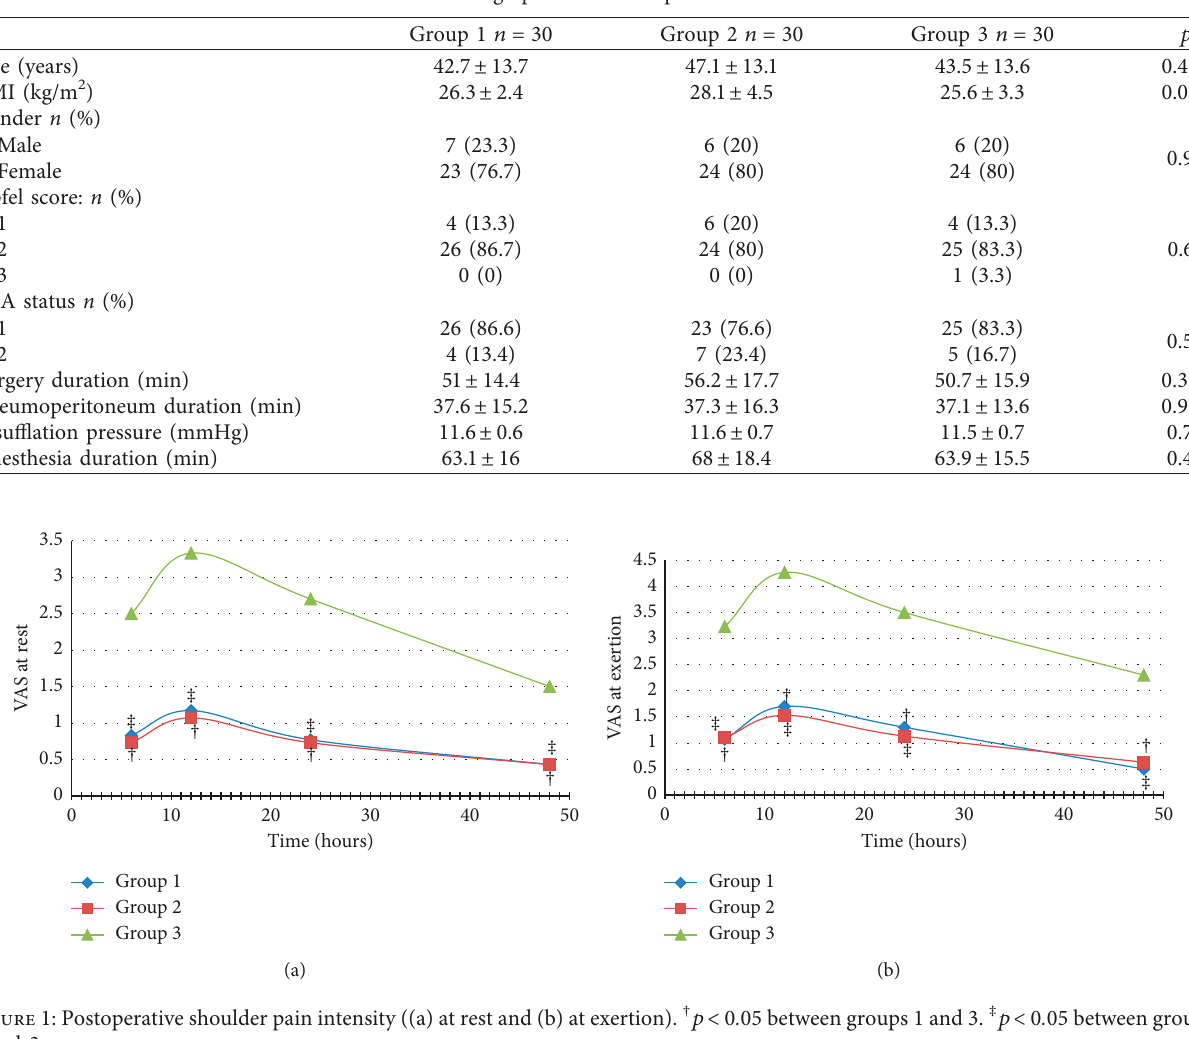
Table 1: Sociodemographic and intraoperative characteristics.